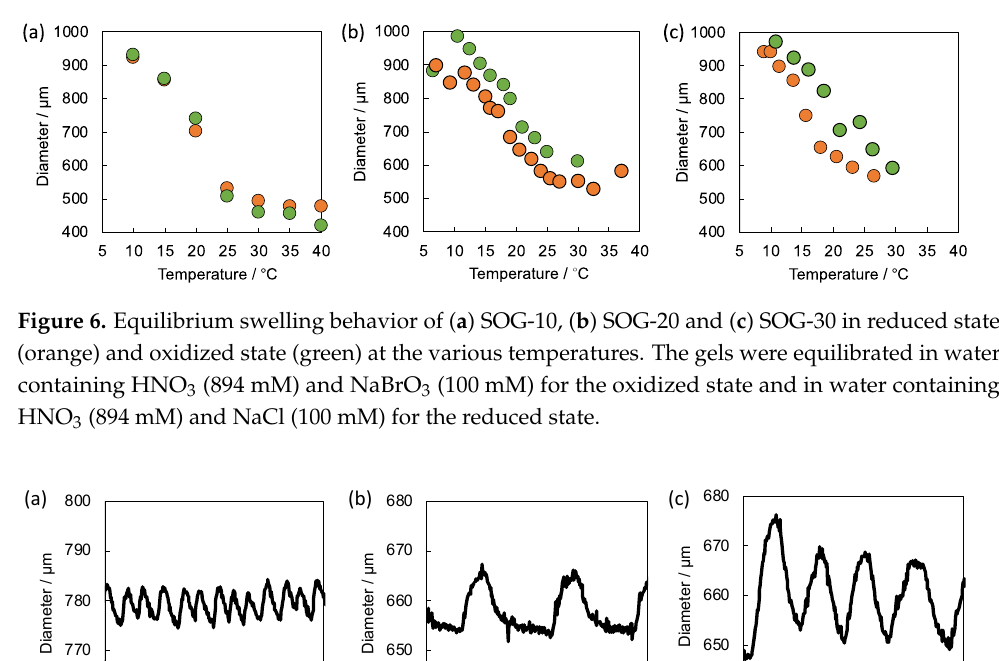
Figure 7. Time profiles of the hydrogel diameter of ( a ) SOG-10, ( b ) SOG-20 and ( c ) SOG-30 during BZ reaction at 20 °C. The catalyst-free BZ solution contains HNO 3 (894 mM), NaBrO 3 (100 mM) and malonic acid (64 mM) at 20 °C.